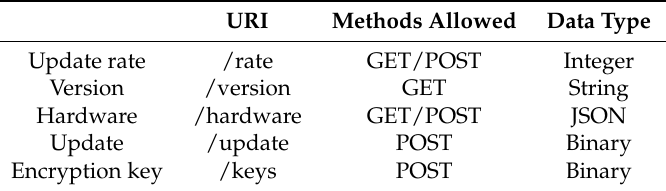
Table 3. A configuration example based on the Constrained Application Protocol (CoAP). URI : Unified Resource Identifier, JSON : JavaScript Object